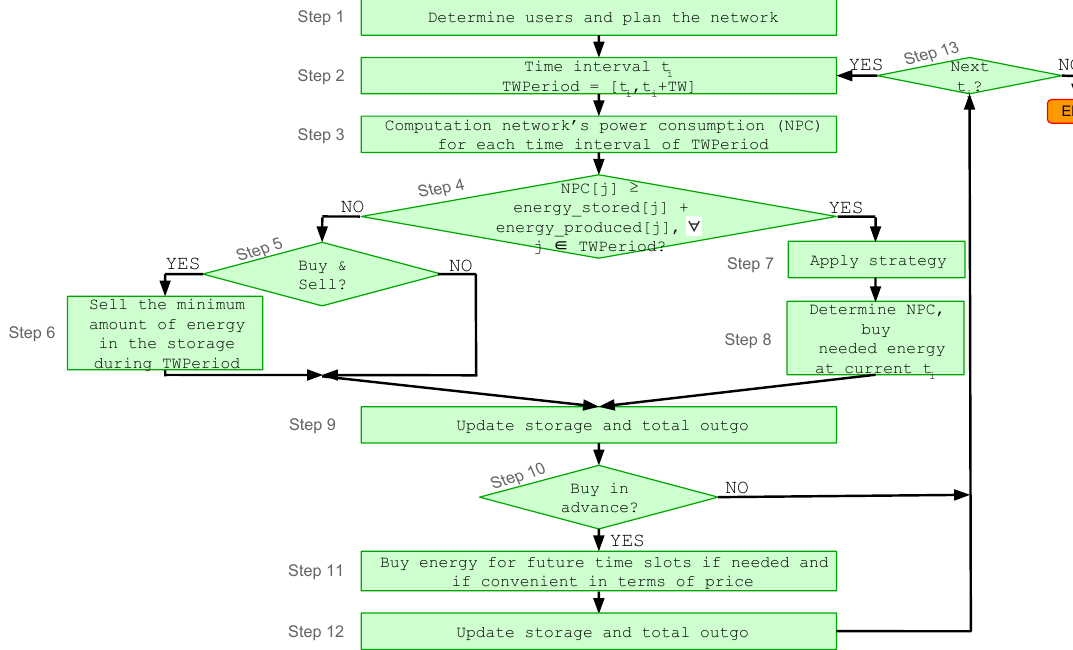
Figure 3. Flowchart when using simple algorithms. NPC, network power